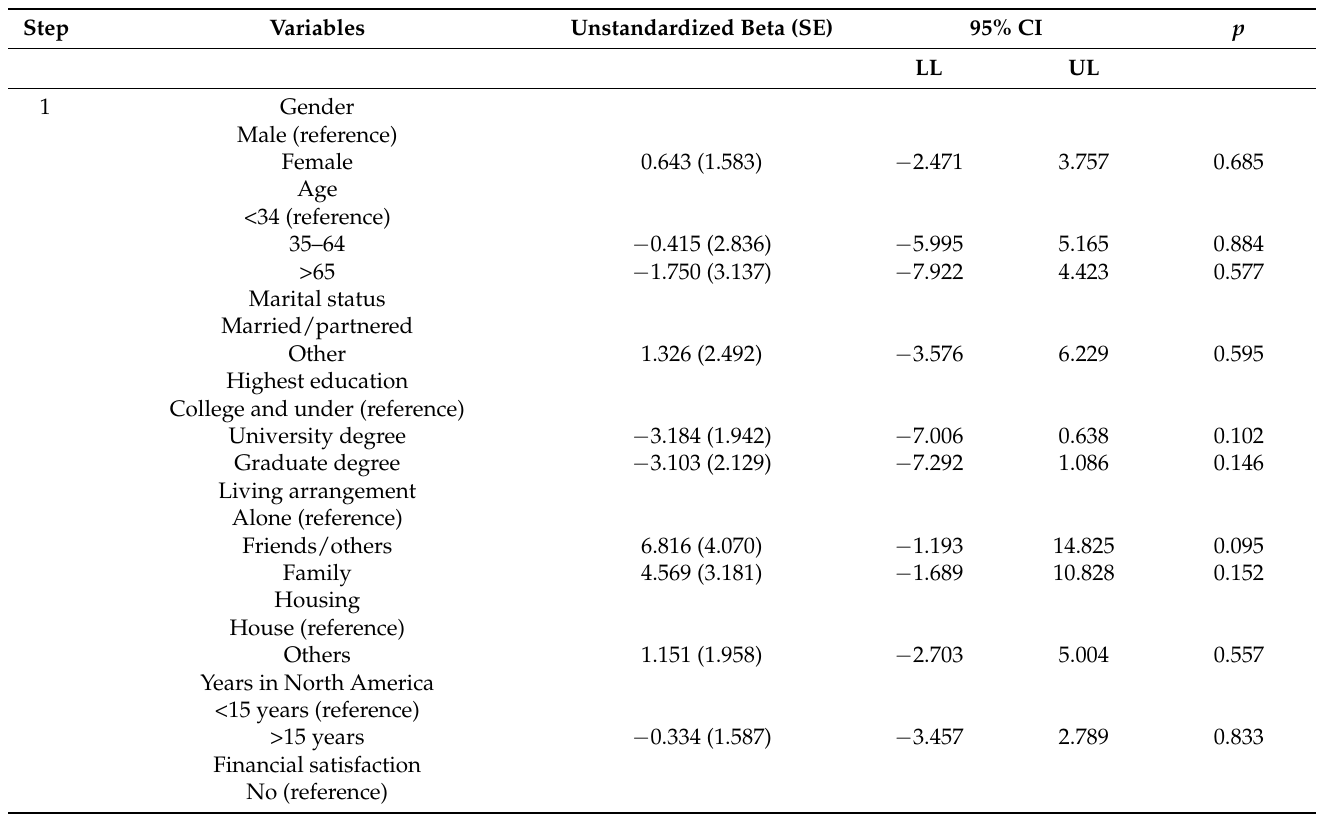
Table 2. Regression results using COVID-19 peritraumatic distress as the